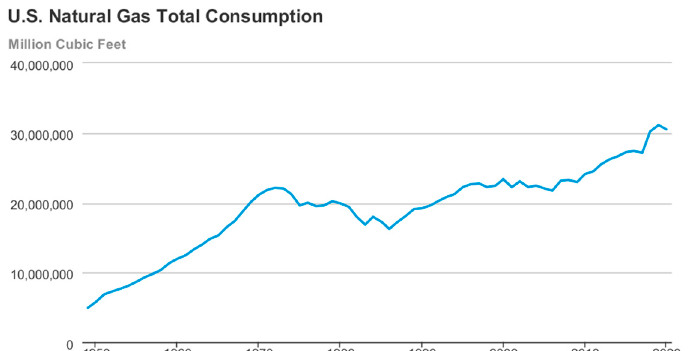
Figure 10. Efficiency of residential cooking appliances using different energy sources: ( a ) System efficiency considerations of utilizing electric appliances. ( b ) Efficiency comparison among cooking appliances [140].